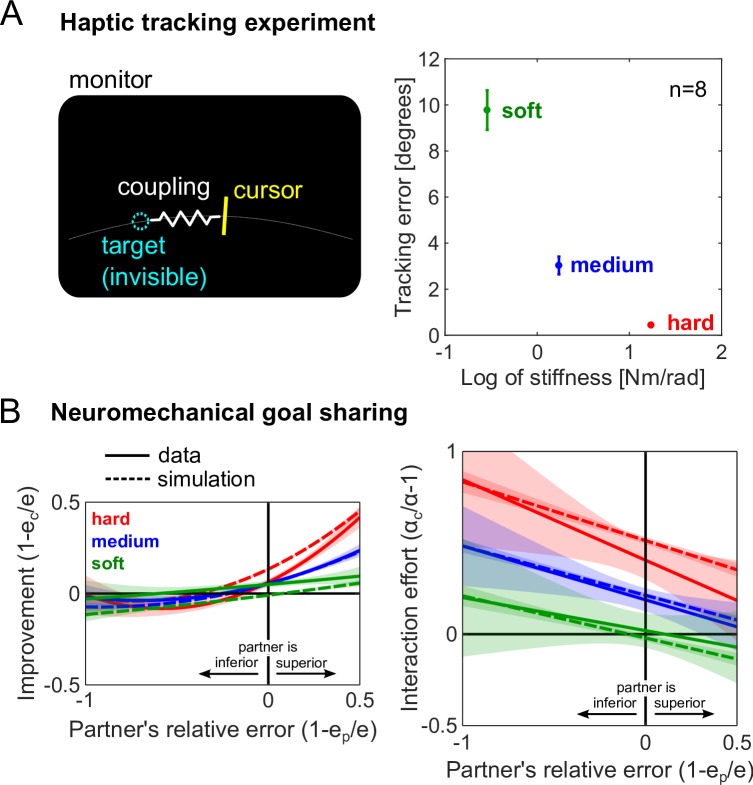
Coupling dynamics influence haptic communication.(A) Haptic tracking control experiment to measure how the tracking error, or the noise in the haptic information, increases with the coupling stiffness (plots are mean±standard error). 8 individually recruited subjects received no visual feedback of the target, instead relying only on the haptic feedback from the elastic connection between the wrist and the target. (B) The tracking errors from the haptic tracking experiment were considered in the neuromechanical goal sharing model, which combines information from vision with the haptic sensing of the partner’s goal to improve tracking performance while taking into account the additional noise in haptic sensing arising from the softness of the interaction. The predictions from this model closely resemble the data, exhibiting modulation of both the improvement and interaction effort due to the coupling stiffness. This shows that the effort expended during interaction is not a strategy per se, but the outcome of maximizing the sensory information of the target’s motion.